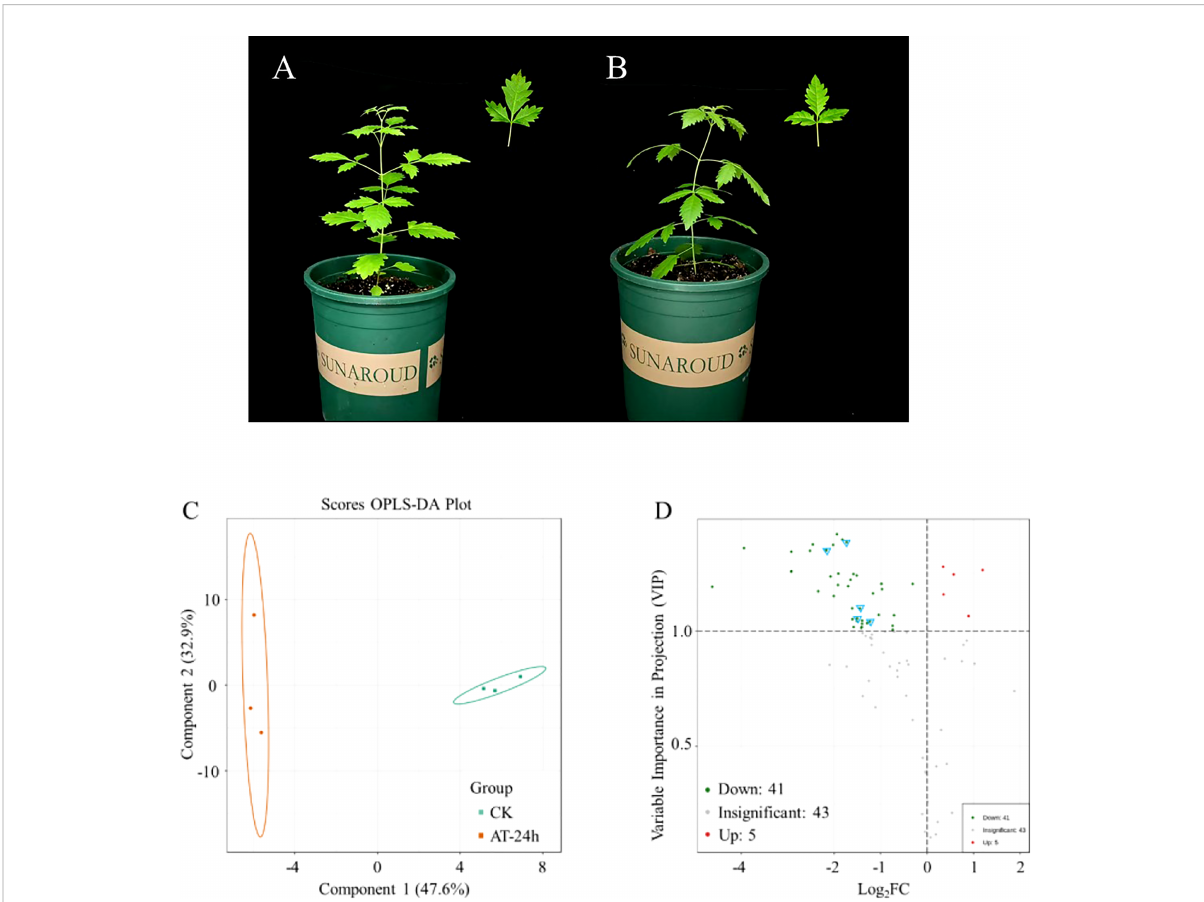
FIGURE 4 Orthogonal partial least squares-discriminant analysis (OPLS-DA) and differential material analysis of V. negundo plant volatile compounds. (A, B) Vitex negundo plants uninfected, and infected by A . gossypii during 24h. (C) Each point represents a sample, the samples of the same group are represented by the same color, with grouping using 95% con fi dence interval. (D) Each point represents a metabolite. When both VIP ≥ 1 and FC ≥ 1 double screening conditions are met, it is considered as a signi fi cantly up-regulated substance. The red point represents an up-regulated differential metabolite, and the green point represents a down-regulated differential metabolite. Gray represents a metabolite detected but not signi fi cantly different. Blue triangle marker points represent substances in terpenoid biosynthesis.